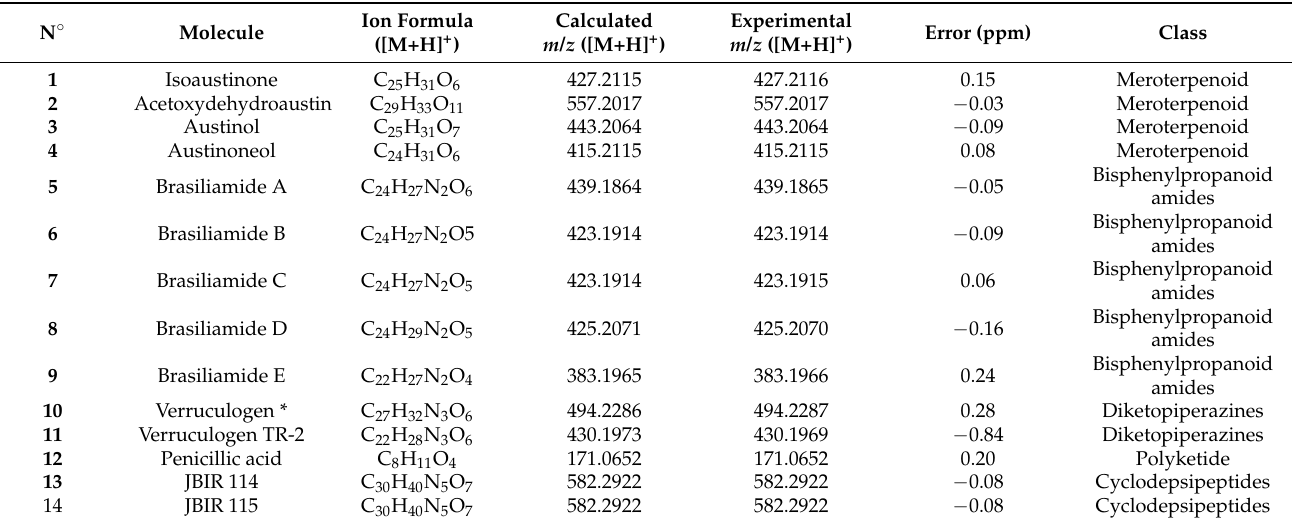
Table 1. HRESI-MS data obtained for all annotated